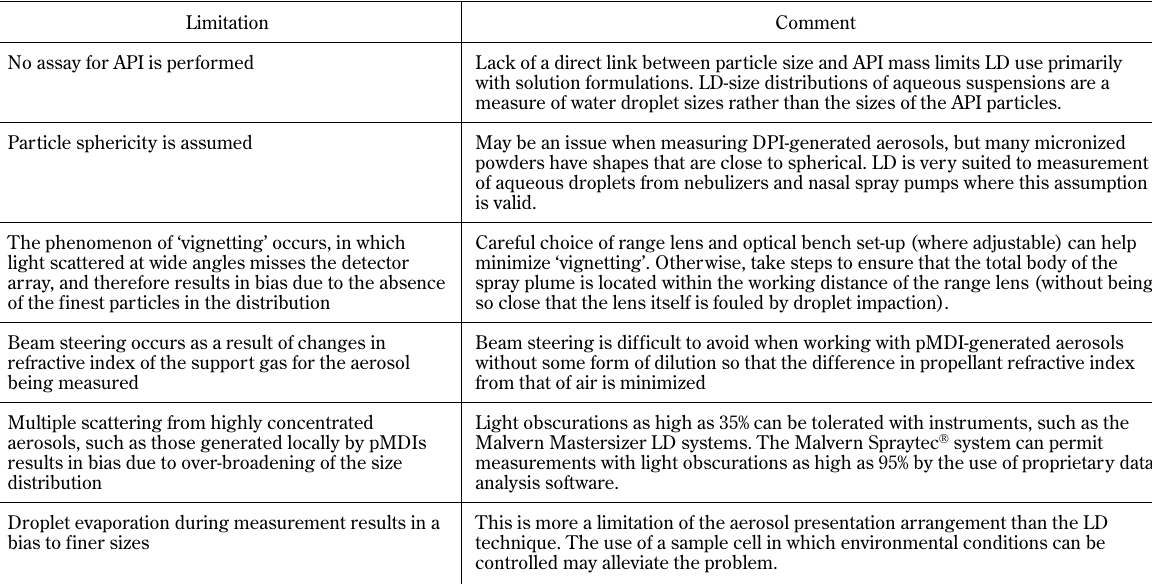
Table 14 Particle size analysis by laser diffractometry (cid:4) Limitations